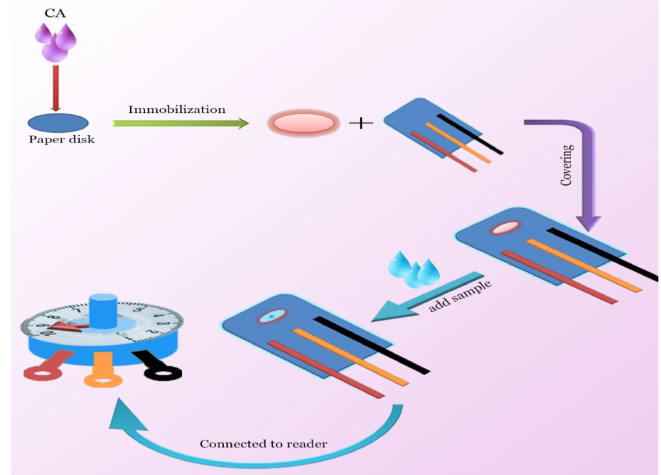
Fig. 3. Schematic of electrochemical method based on CA by using screen printed